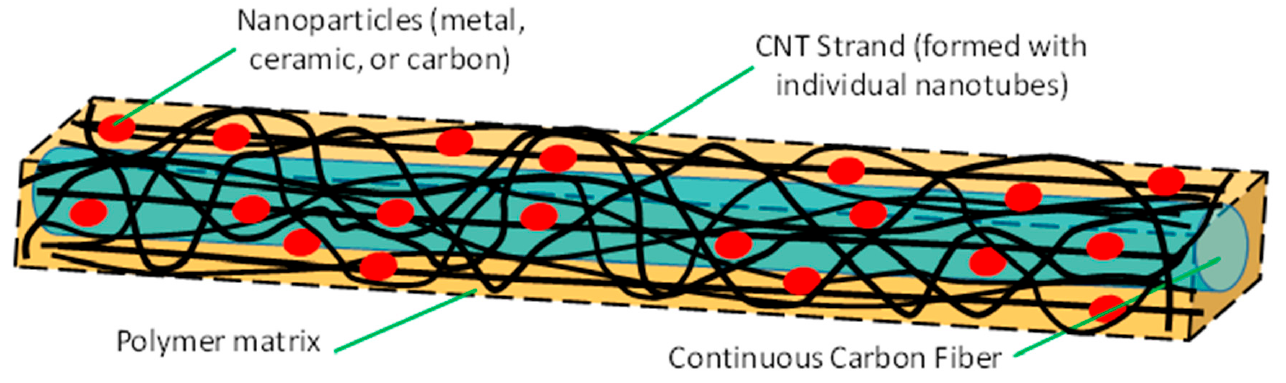
Figure 7. Schematic of an idealized unit cell of a carbon hybrid material.